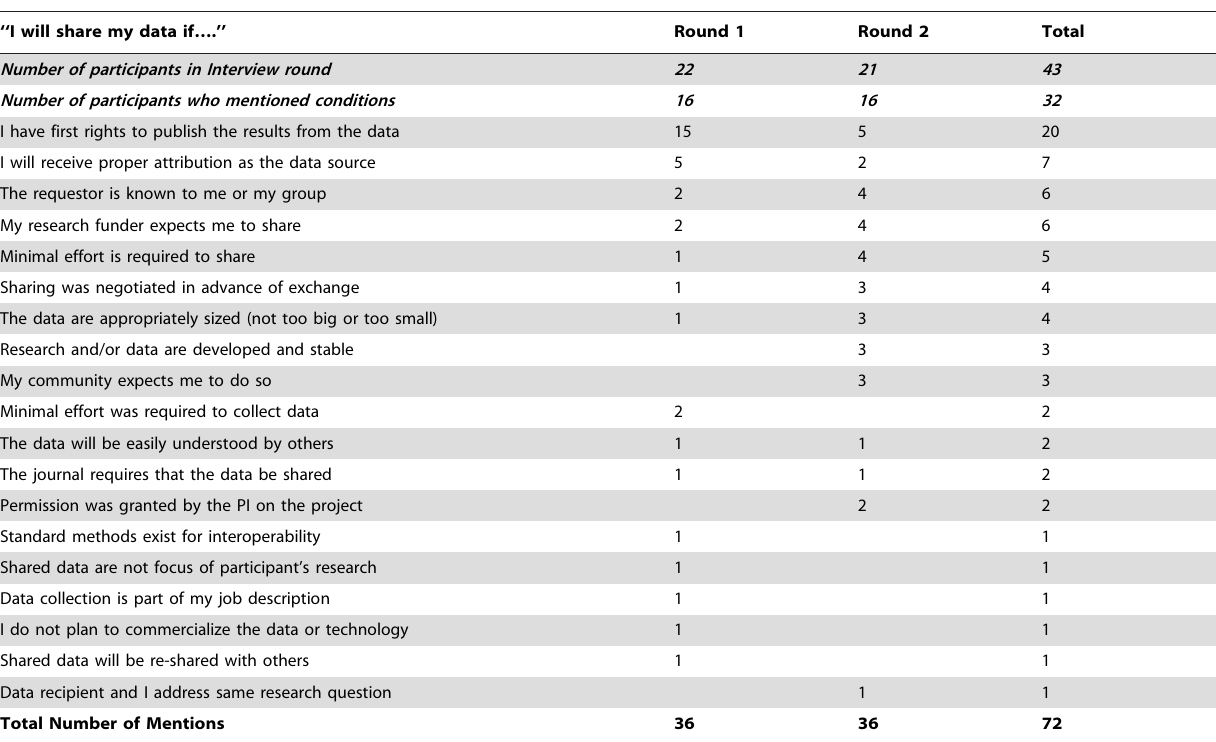
Table 2. Conditions for data